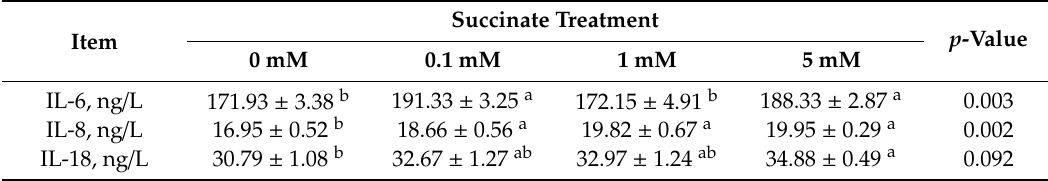
Table 8. E ff ects of sodium succinate at di ff erent levels on the protein abundances of inflammatory cytokines in IPEC-J2 cells.